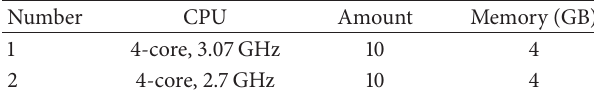
Table 1: Hardware configuration parameters.